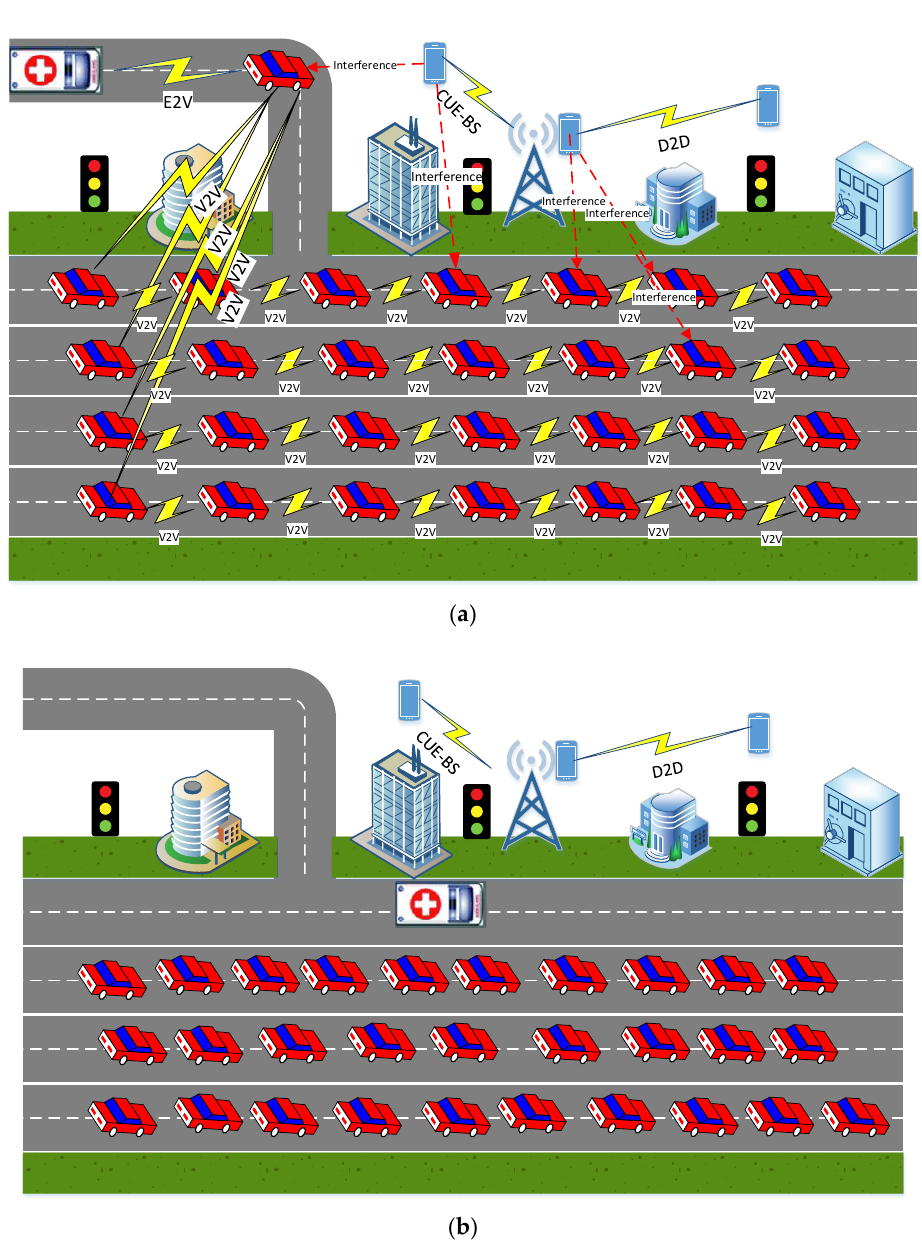
Figure 1. System model for emergency vehicle communications ( a ) before receiving the emergency message and ( b ) after receiving the emergency message.